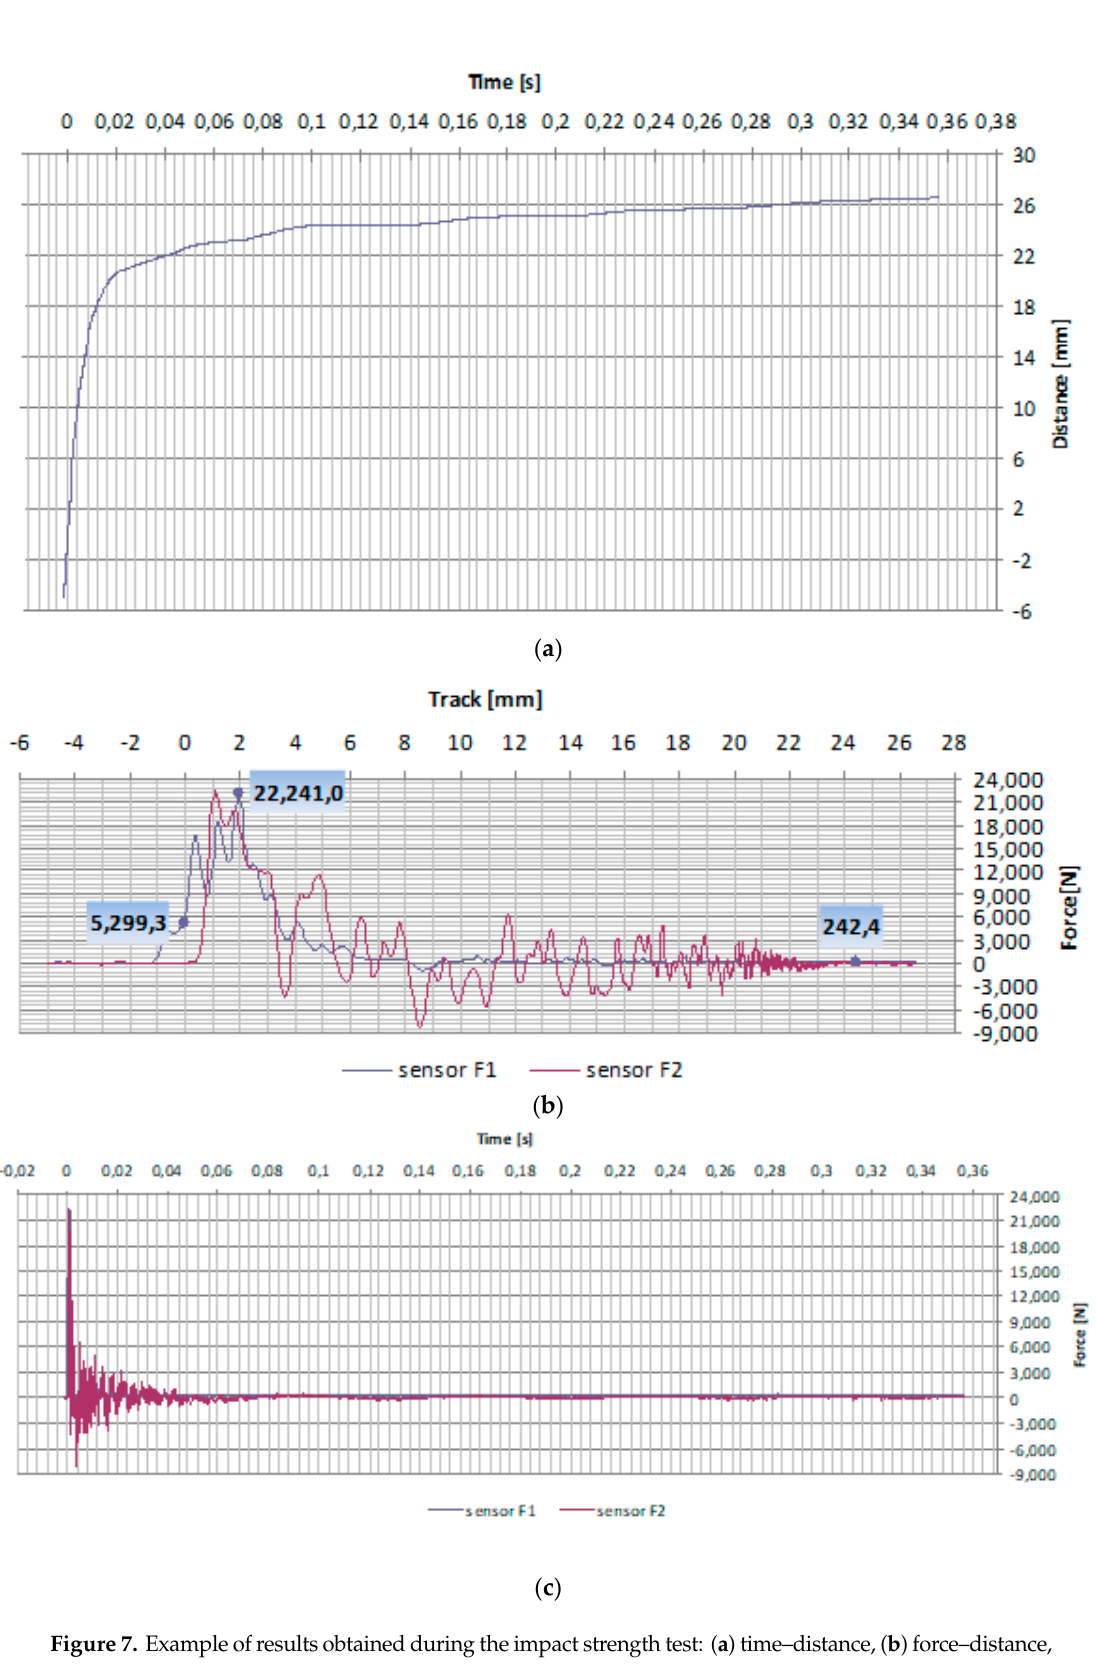
Figure 7. Example of results obtained during the impact strength test: ( a ) time–distance, ( b ) force–distance, ( c ) force–time.